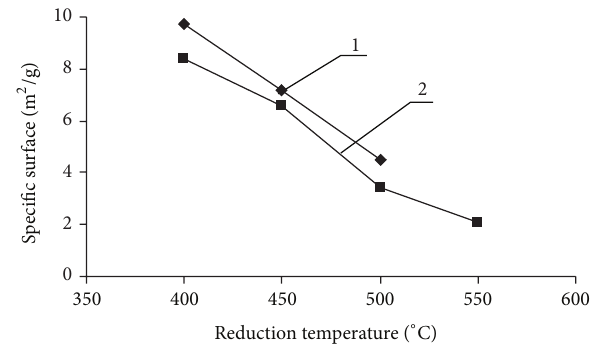
Figure 3: The dependence of the specific surface of iron on reductiontemperature:(1)ironpowderobtainedfromFeOOHdried at 25 ∘ C, (2) iron powder obtained from FeOOH dried at 110 ∘